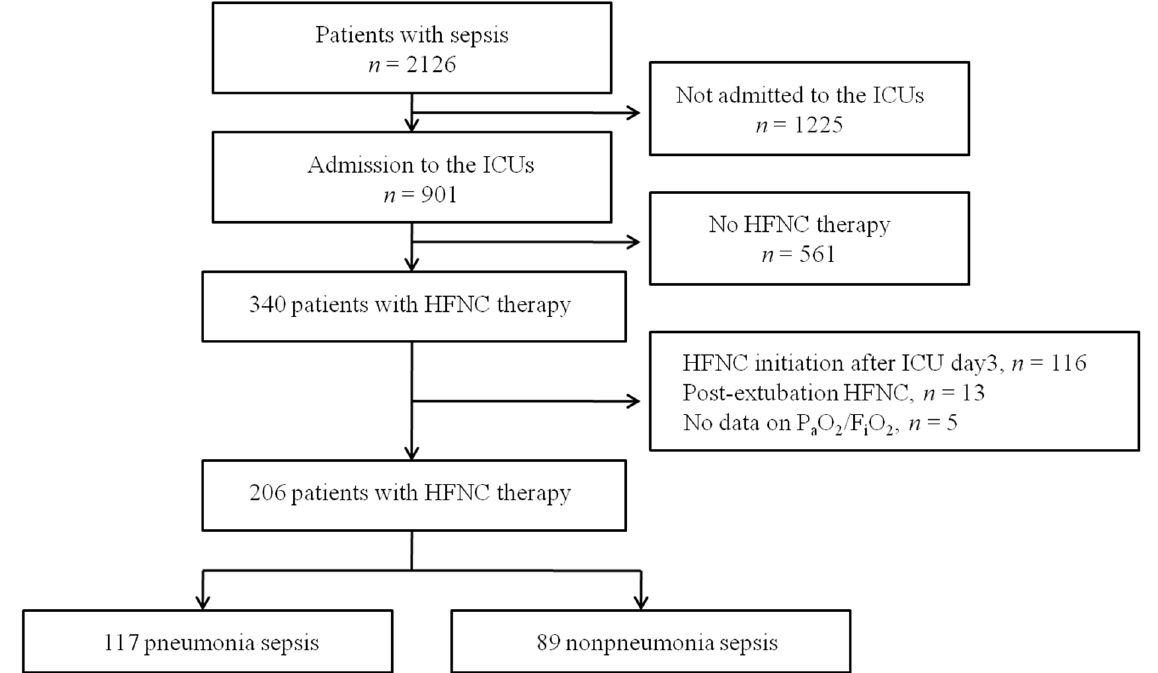
Figure 1. Flow chart of patient enrolment. HFNC: high-flow nasal cannula; ICU: intensive care unit. Table 1. Baseline characteristics and treatments among enrolled patients ( n = 206).